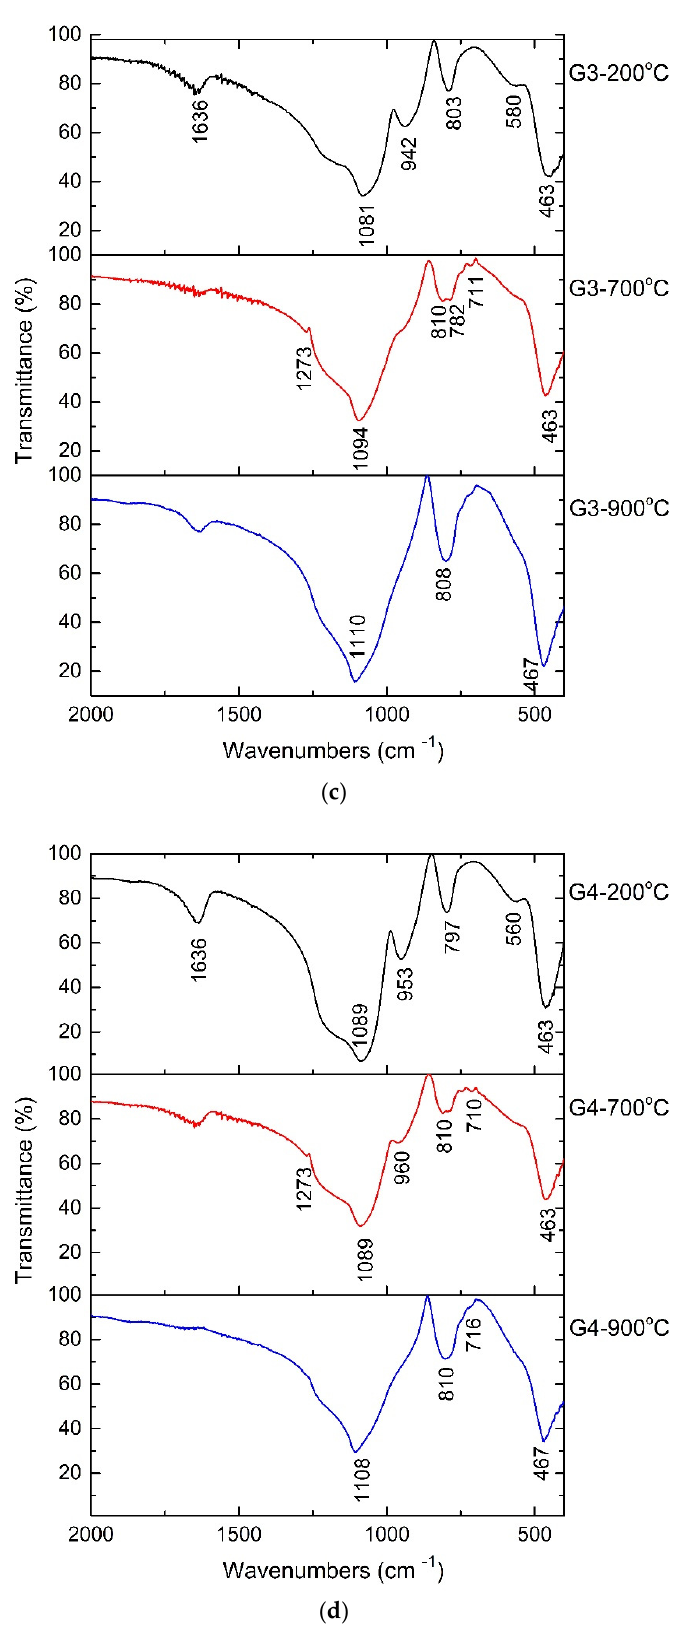
Figure 3. FTIR spectra of powders heat treated at 200 ◦ C, 700 ◦ C and 900 ◦ C: ( a ) G1; ( b ) G2; ( c )